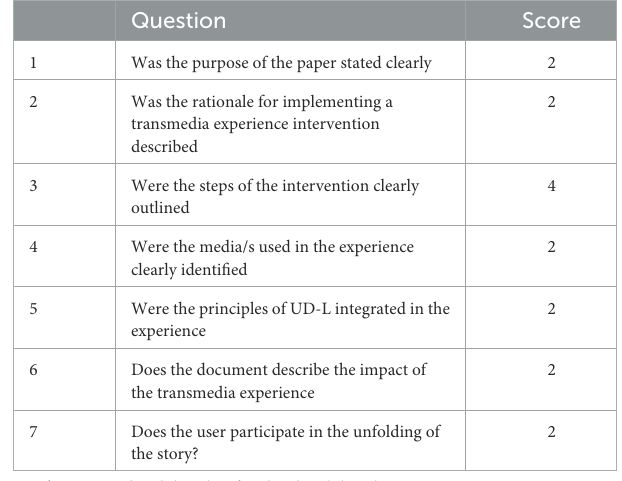
TABLE 2 Quality criteria questions and